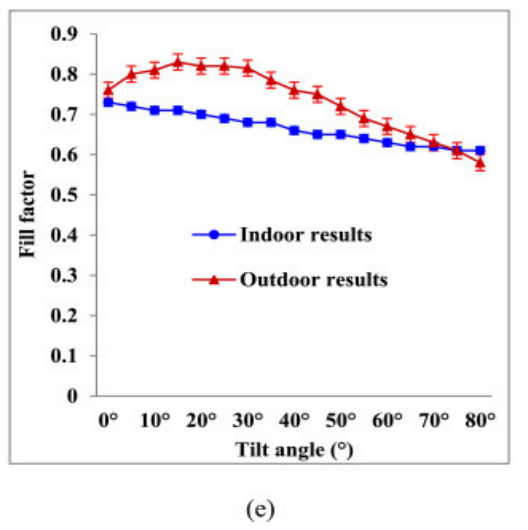
Figure 18. Electrical parameters of a PV system as a function of tilt angle at 750 W/m 2 . ( a ) Open- circuit voltage (Voc); ( b ) short-circuit current (Isc); ( c ) maximum power point current (Impp); ( d ) maximum power point voltage (Vmpp); and ( e ) fill factor (FF) [105].